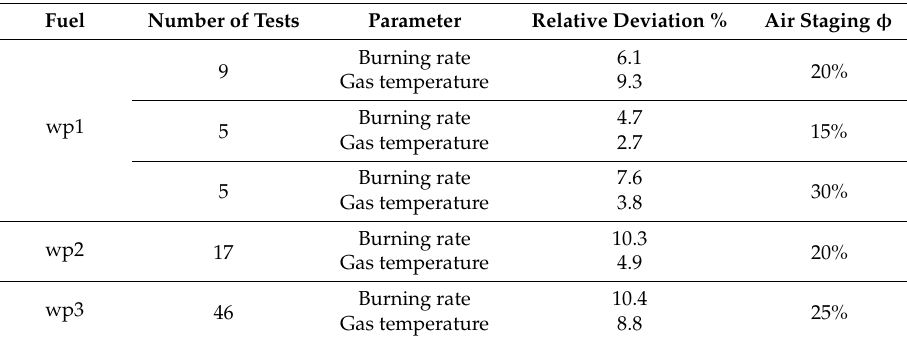
Table 2. Measurement repeatability for the main parameters.